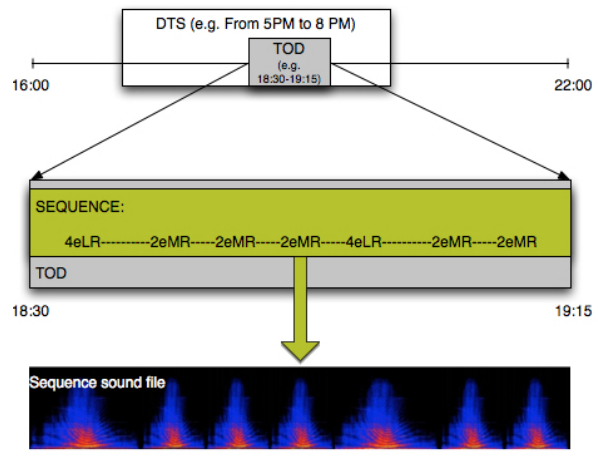
Figure 2: Sequence of airport events comprising the departure of five twin-engine mid-range (2eMR) and two four-engines long-range (4eLR) aircraft in a 45 minutes time slot, and spectrogram of the synthesized sound